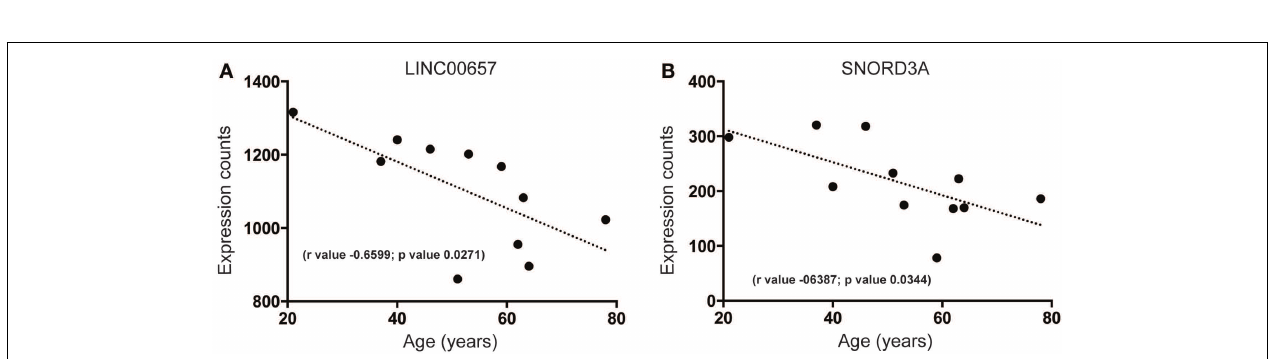
FIGURE 4 | Highly expressed lncRNAs that increase in expression during aging in the human SEZ . A significant increase during aging in the human SEZ is observed in the expression levels of (A) MALAT1. Insignificant,